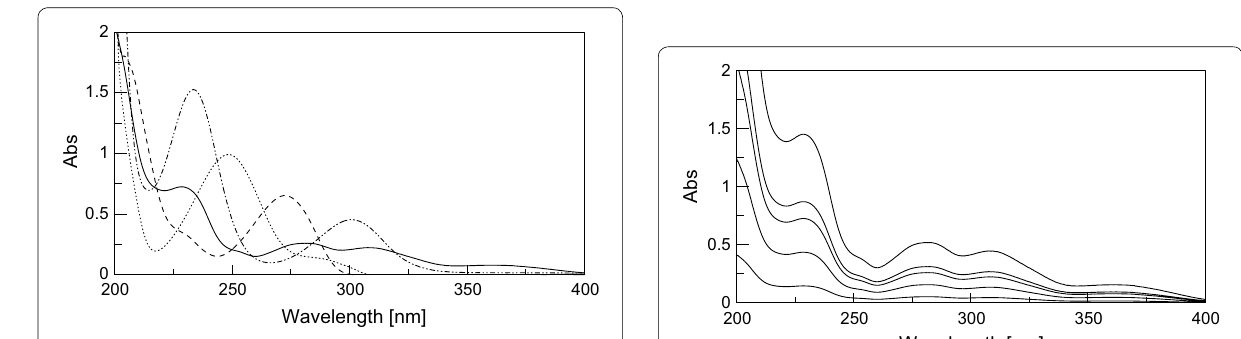
Fig. 2 Zero order absorption spectra of 10 μg/mL DRO ( solid line ), 10 μg/mL PCT ( dotted line ), 10 μg/mL CAF ( dashed line ) and 10 μg/mL PAP ( dashed dotted line )